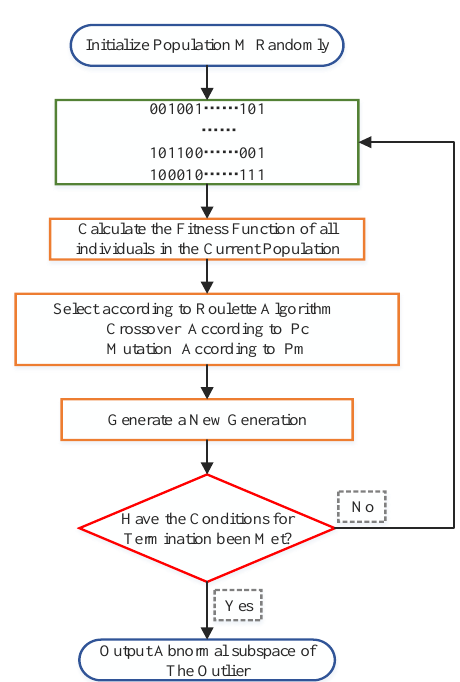
Figure 4. Genetic algorithm